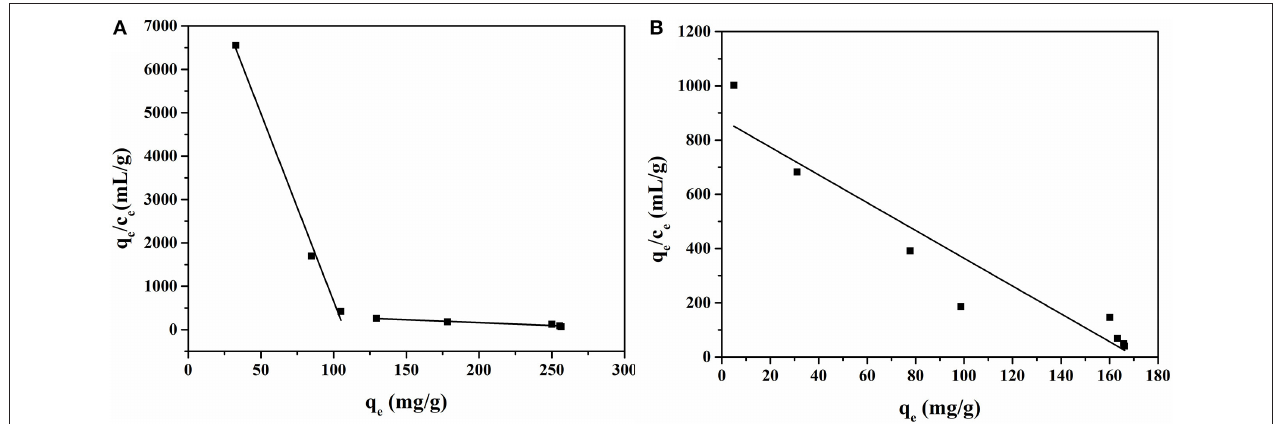
FIGURE 7 | Scatchard plot of MIP1 (A) and NIP1 (B) for ACT.